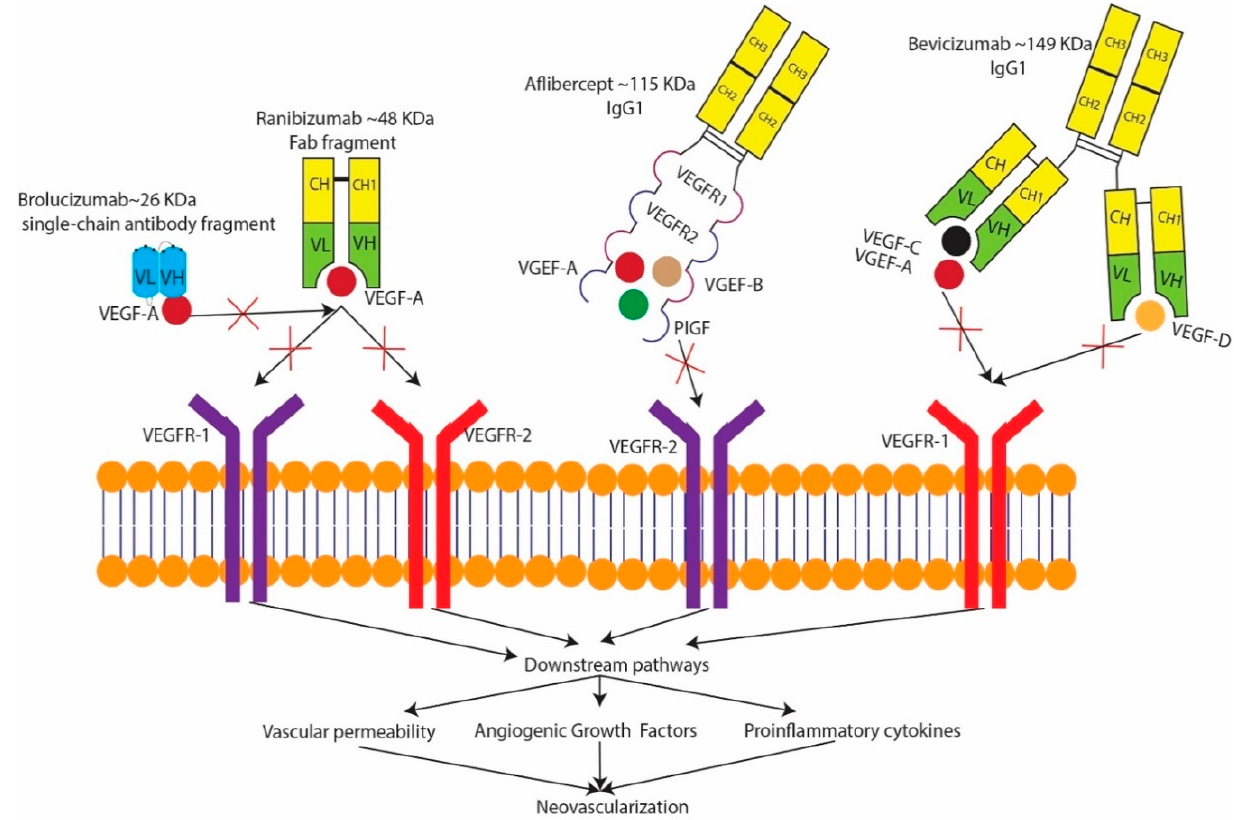
Figure 4. Mechanism of anti-VEGF drugs.